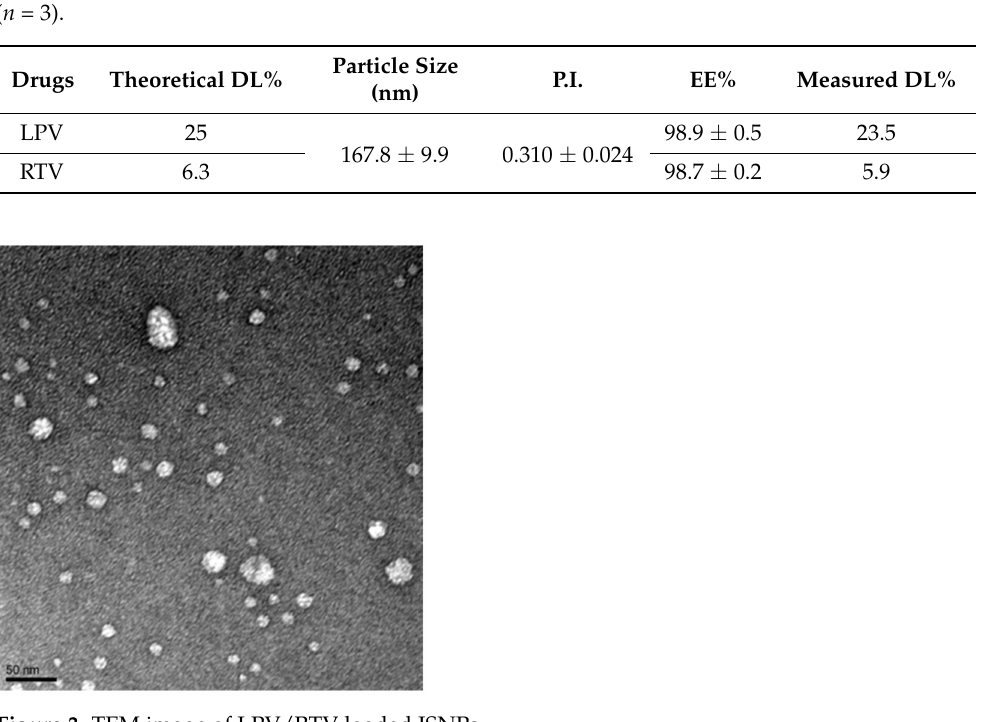
Figure 3. TEM image of LPV/RTV-loaded